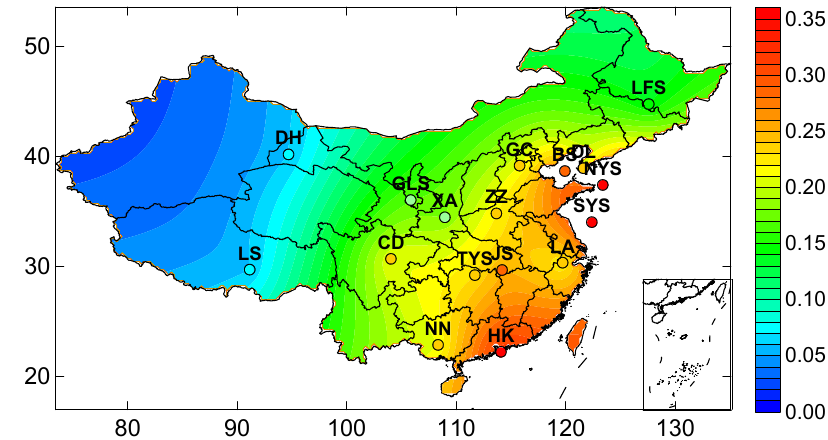
Figure 2. Distribution of the hygroscopic parameter ( κ ) over China obtained by kriging space interpolation from measurements at 17 locations, indicated by the circles. The values of κ at these locations were calculated from aerosol chemical components or hygroscopic parameters from Yeung et al. (2014), Zhang et al. (2012) and Fu et al. (2015) [37–39].